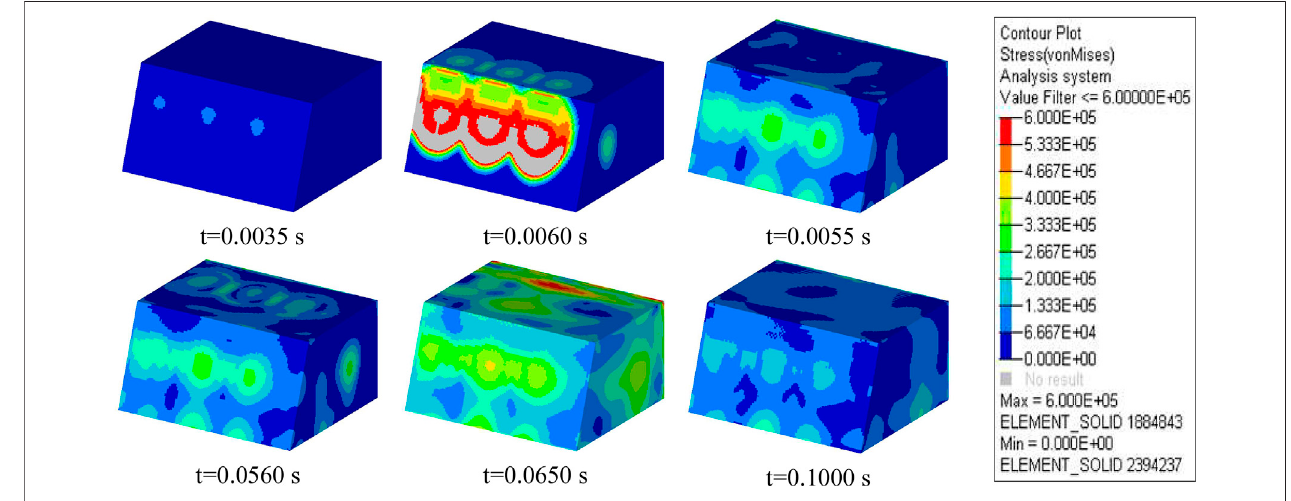
FIGURE 7 | Cloud diagram of short-delay blasting stress distribution.